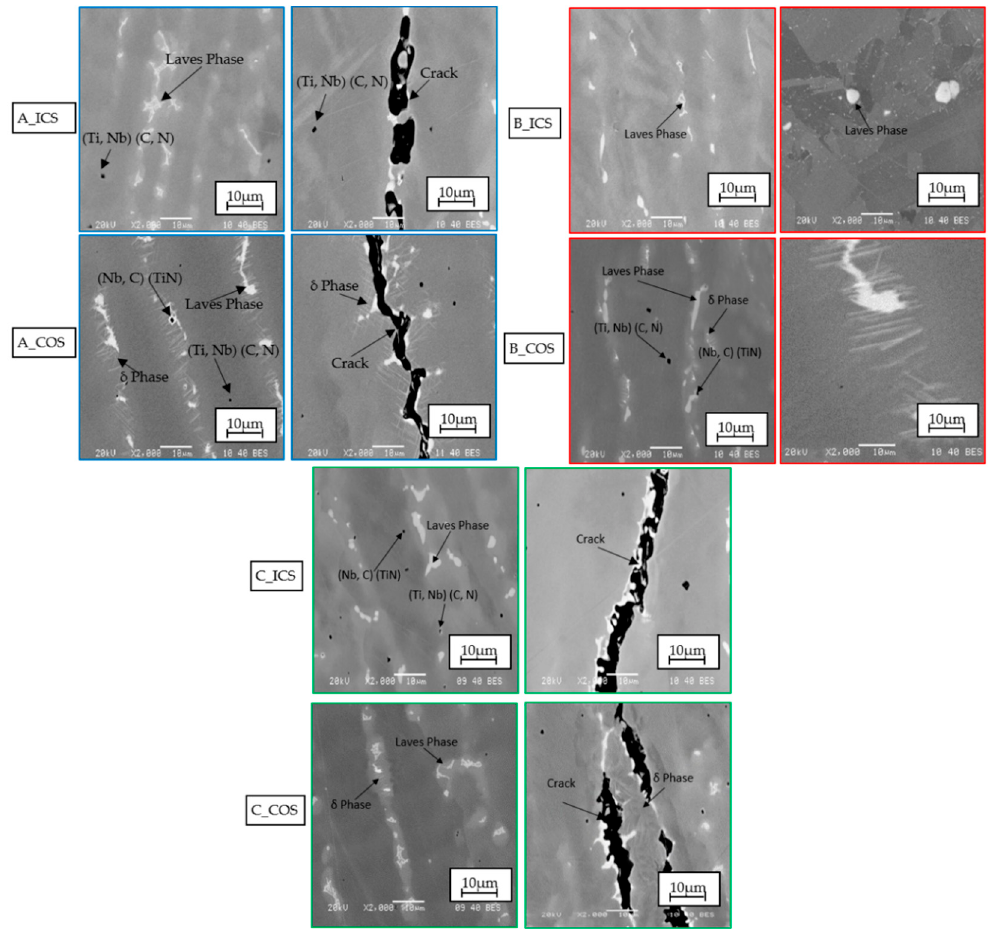
Figure 12. SEM graphs of the precipitated phases observed in the microstructure of the ICS and COS samples .